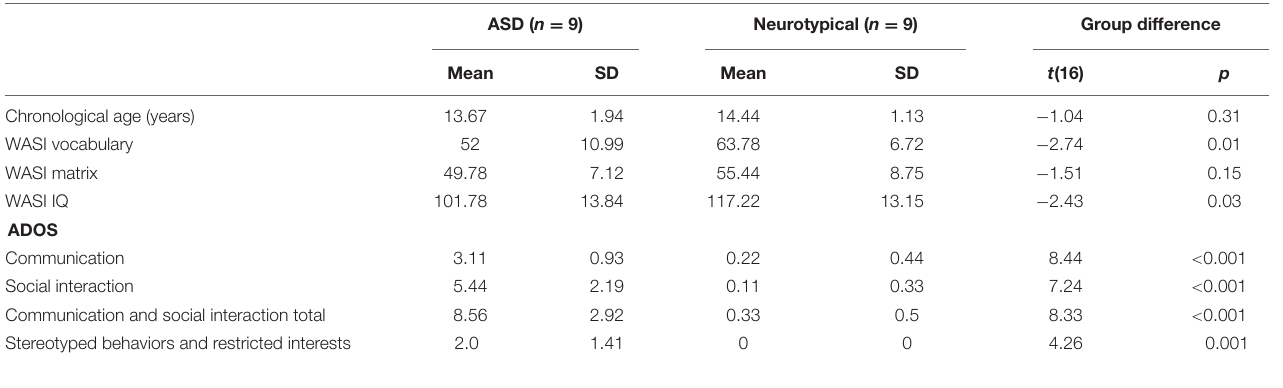
TABLE 1 | Participant characteristics and clinical